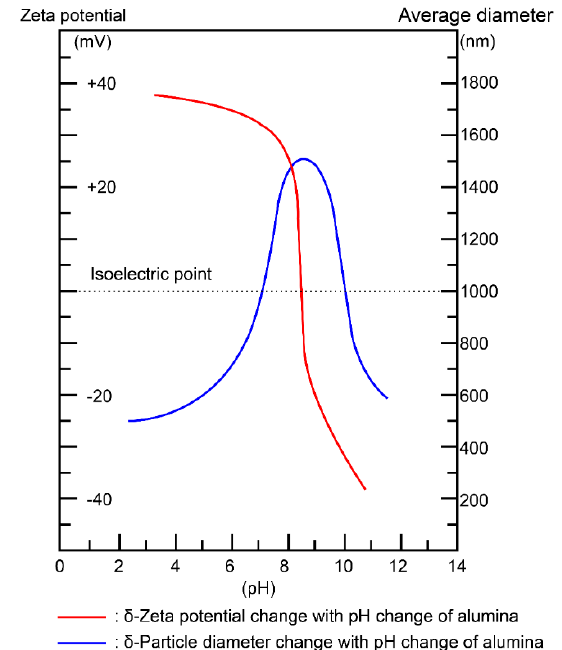
Figure 4. Dependence of particle size and zeta potential of alumina particles on pH (adapted from Otsuka Electronics Korea Co. Ltd.).